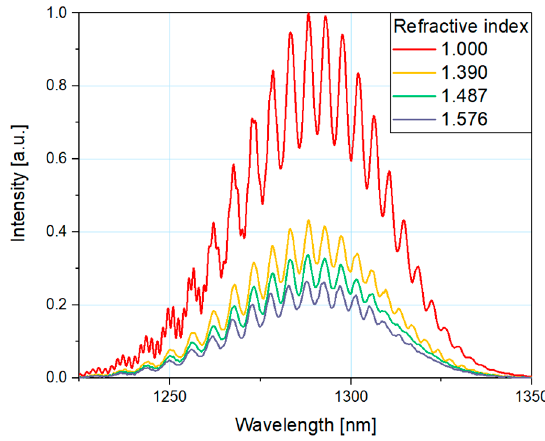
Figure 6. Measured response of the fiber-optic interferometer for a microsphere with ZnO layer.